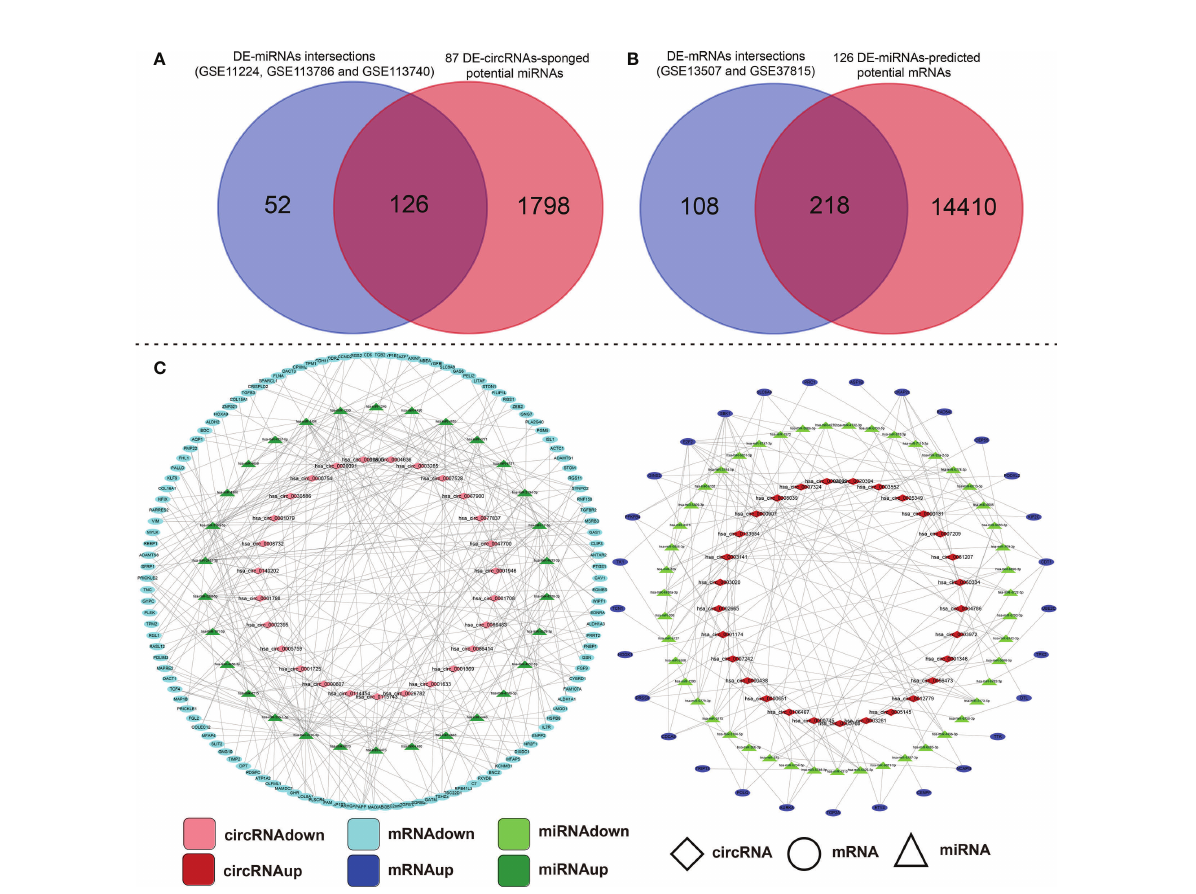
FIGURE 2 Construction analysis of the ceRNA network of the DE-circRNA, DE-miRNA, and DE-mRNA identi fi ed in BCa tissues compared with their adjacent non-cancerous tissues. (A) Intersection of DE-circRNA-targeting miRNAs and common DE-miRNAs of GSE11224, GSE113786 and GSE113740 datasets. (B) Conjoint analysis of the A-mentioned 126-intersection-DE-miRNA binding mRNA targets and DE-mRNA of GSE13507 and GSE37815 datasets. (C) The circRNA-miRNA-mRNA ceRNA network was established and visualized by Cytoscape 3.7.1 that based on the above data. ceRNA, competing endogenous RNA; circRNA, circular RNA; miRNA, microRNA; differentially expressed-,